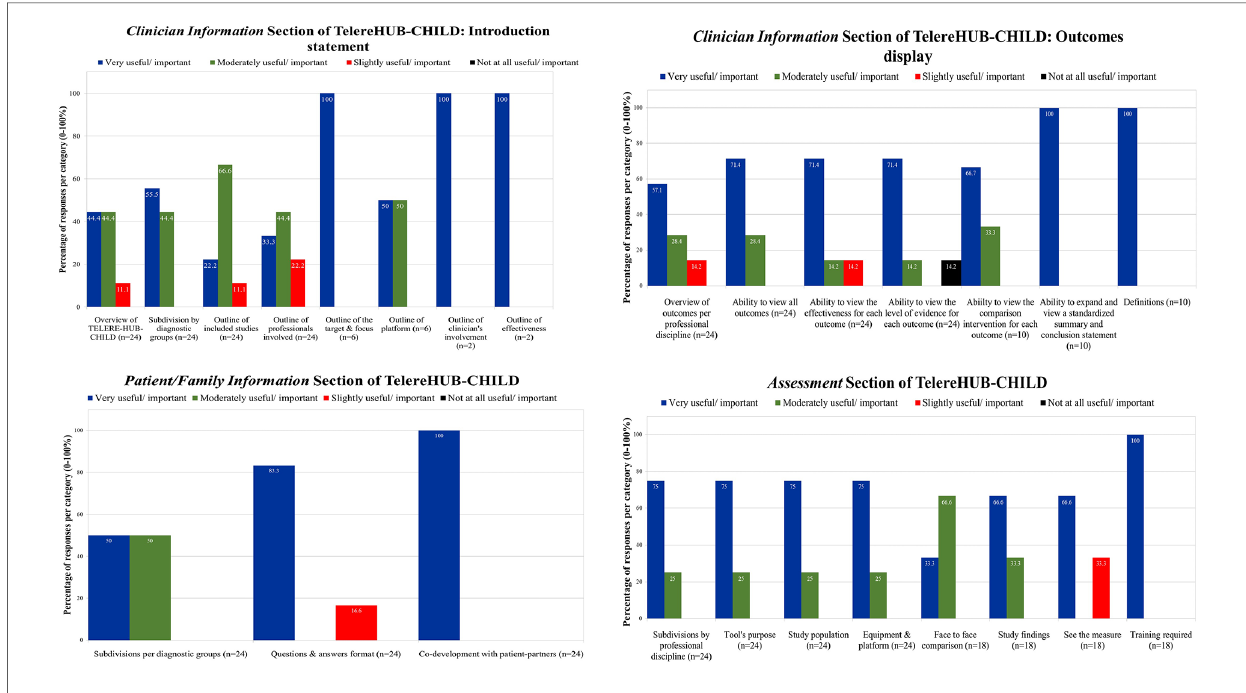
FIGURE 2 Importance and usefulness ratings of clinical partners on the Tele-Treatment and Tele-Assessment sections of TelereHUB-CHILD.